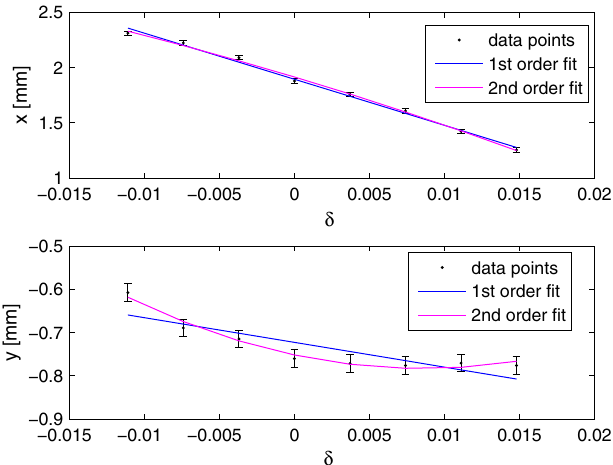
FIG. 3. (Color) Example of a dispersion measurement at a single BPM at FLASH. Upper plot: horizontal plane. Lower plot: vertical